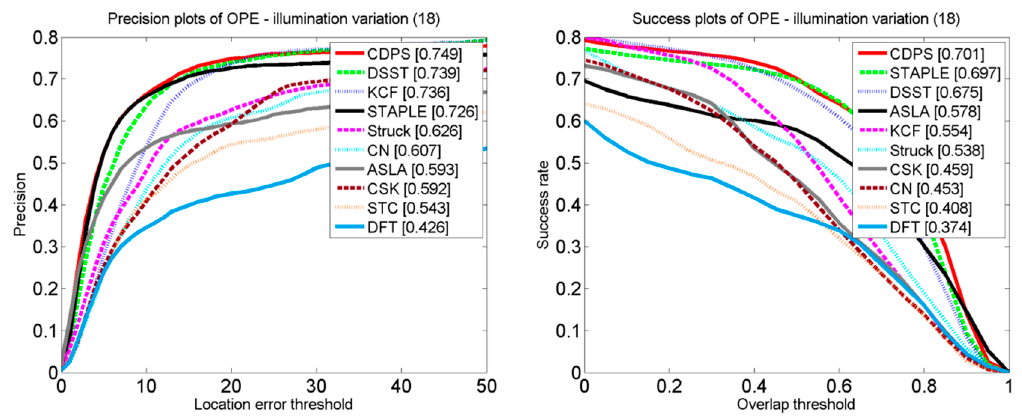
Figure 5. Attribute-based evaluation of precision and success plots comparing algorithms with 10 CF-based trackers over seven challenges of deformation: in-plane ration, scale variation, out-of-plane ration, occlusion, motion blur, and illumination variation. The number of sequences for each attribute is shown in brackets.